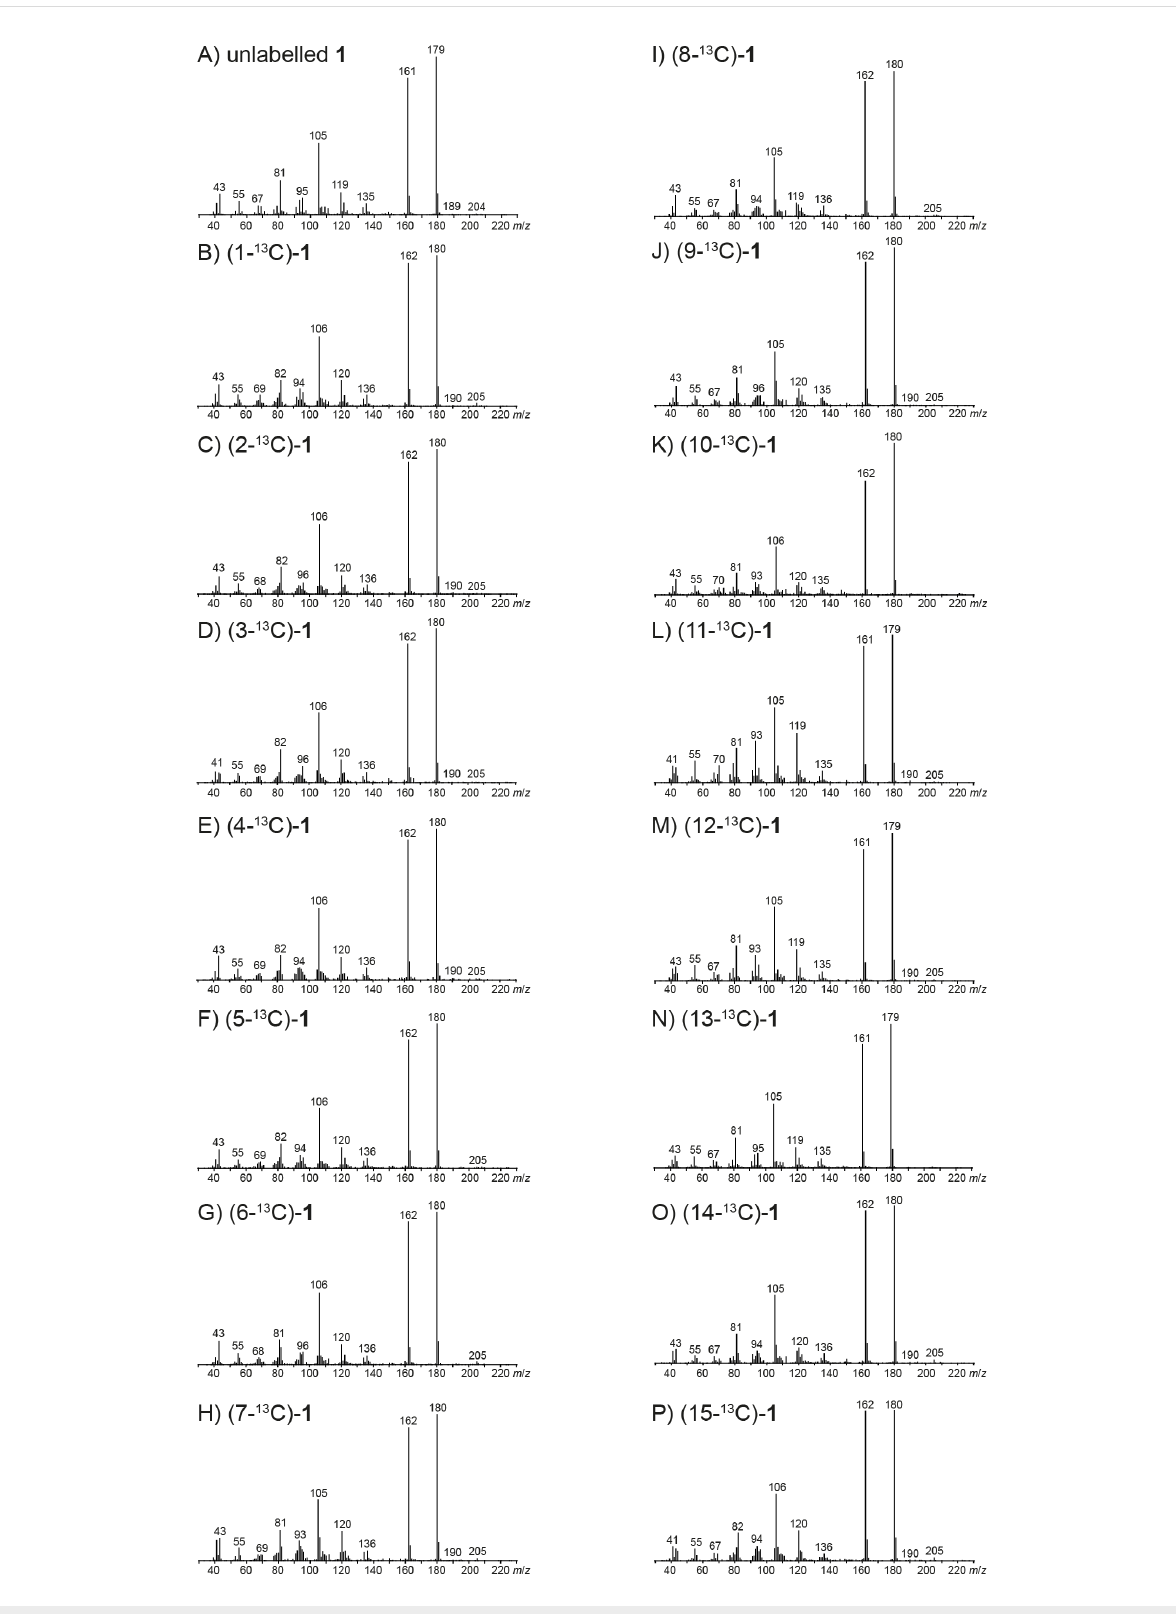
Figure 1: Mass spectra of unlabelled 1 and all fifteen positional isomers of ( 13 C 1 )- 1